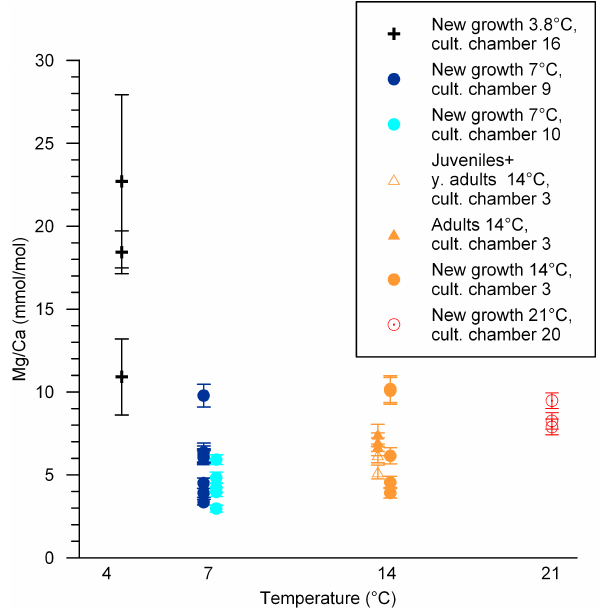
Fig. 5. Mg/Ca (mmol/mol) over the experimental temperature gra- dient, presented by sample type (new growth and size classes). For 7 and 14 ◦ C, data is presented in two columns to allow visualization of result from different samples types, see legend for